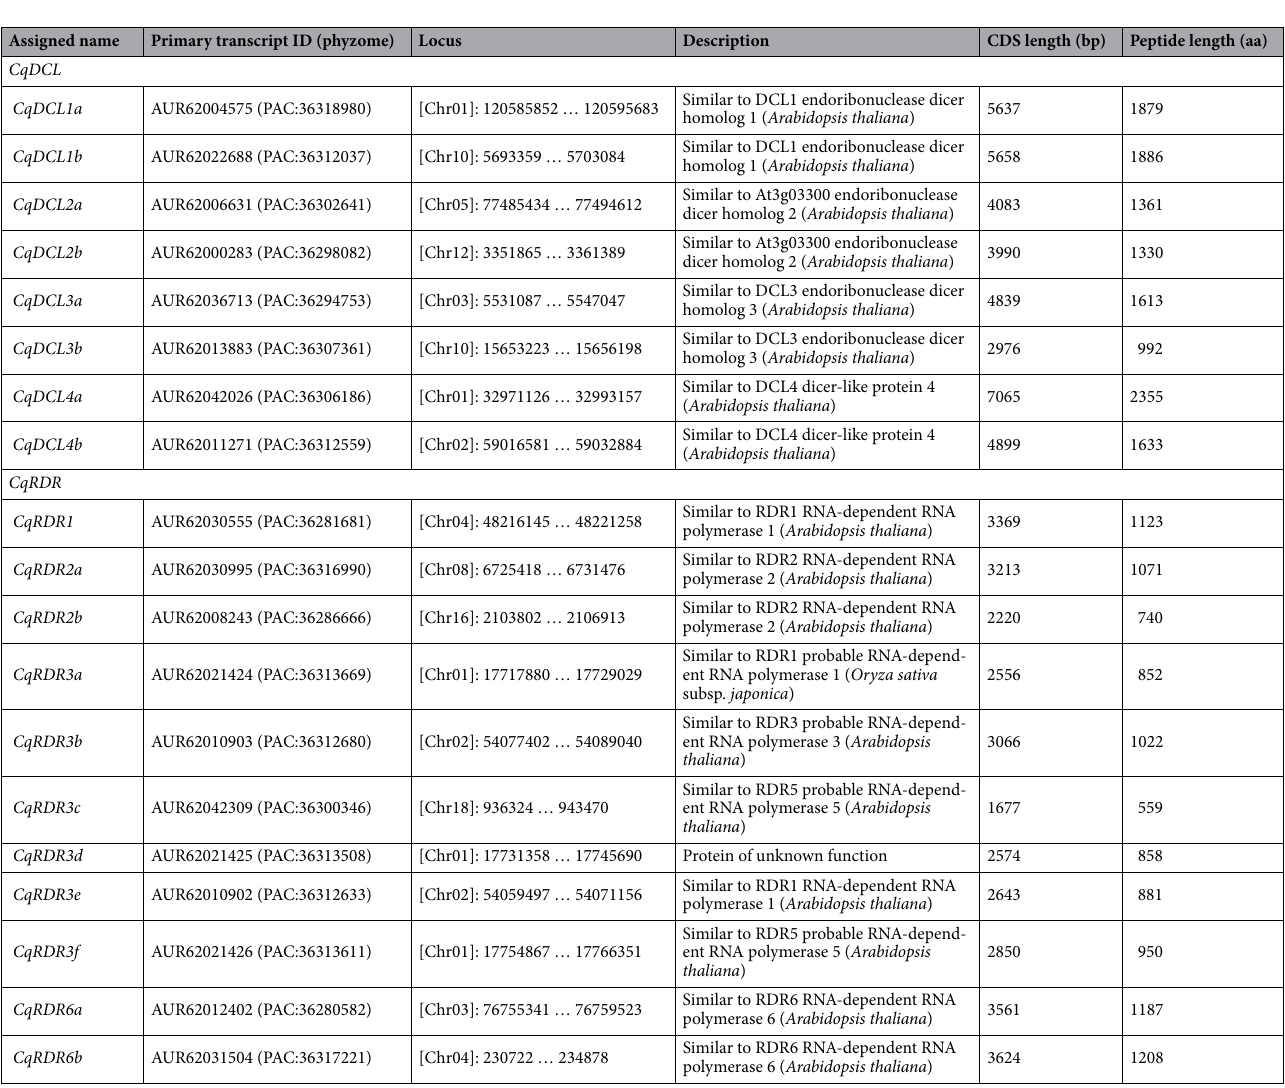
Table 2. Information about the predicted CqDCL and CqRDR gene